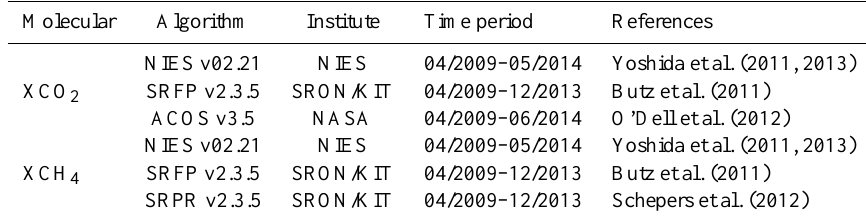
Table 1. TANSO-FTS/GOSAT retrieval algorithms. Molecular Algorithm